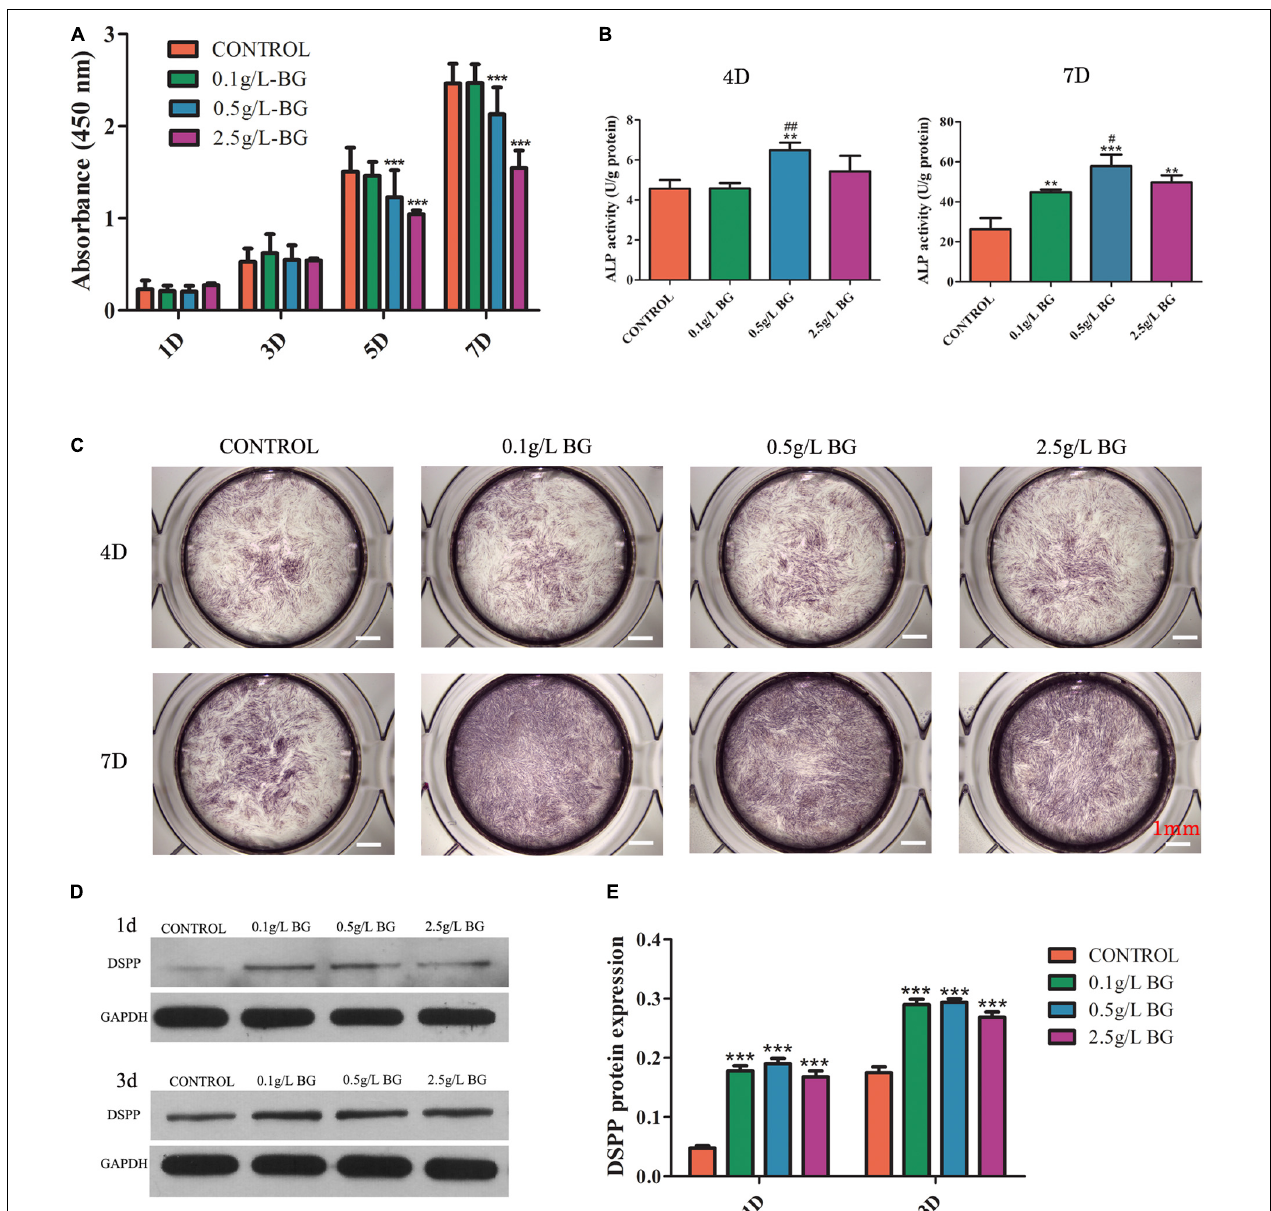
FIGURE 3 | Effect of BG ionic extraction on SHEDs proliferation and odontogenic differentiation. (A) CCK8 assay, (B) ALP activity, (C) ALP staining (scale bars: 1 mm), (D) Western blot assay, and (E) Quantitative analysis of western blots. The data are presented as mean ± SD from independent experiments ( n = 3). Significant effect of treatment: compared to control, * P < 0.05, ** P < 0.01, *** P < 0.001; compared to 0.1 g/L-group, # P < 0.05, ## P < 0.01. D: